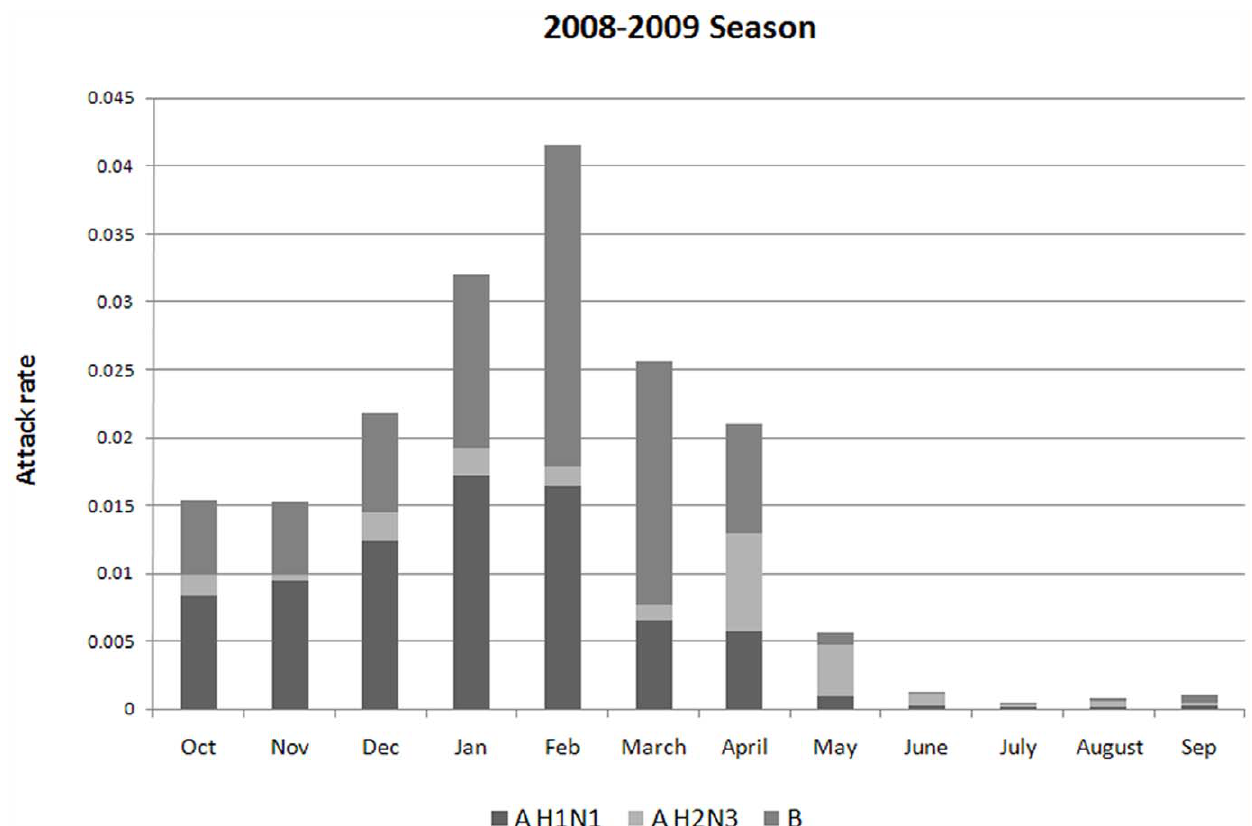
Figure 2. Monthly distribution of the probability of ILI. Weekly influenza surveillance report form CDC [22]. 2008–2009 influenza season, week 39 ending October 3, 2009. Data shows only seasonal influenza and pandemic strain, 2009 influenza A (H1N1) virus, has been omitted.